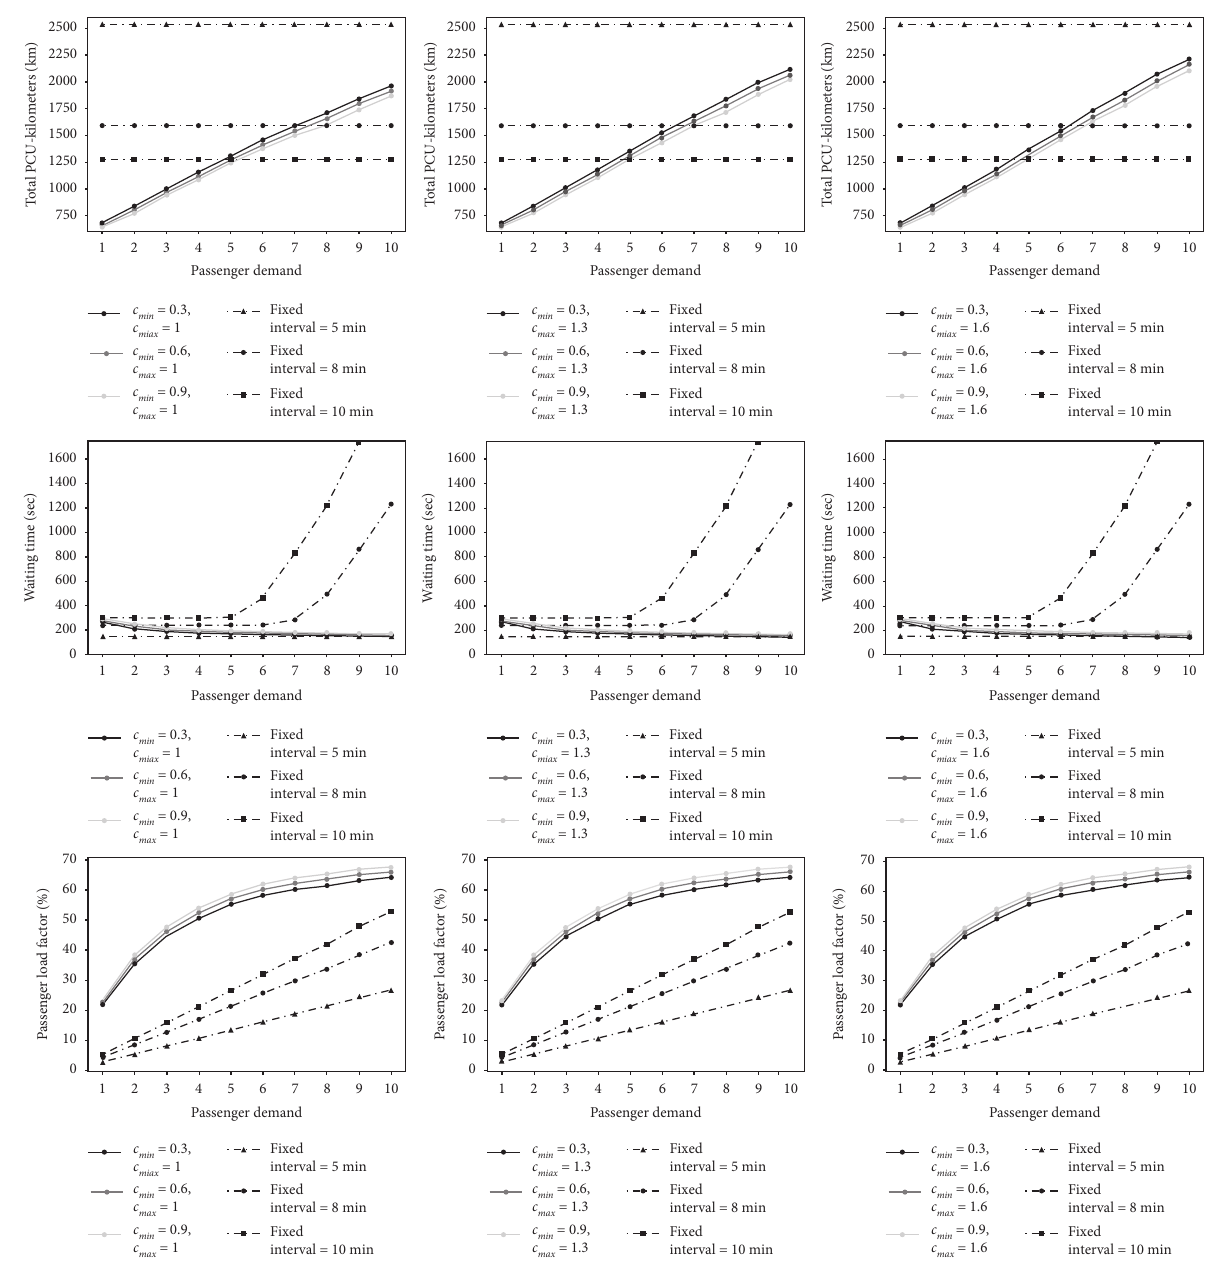
Figure 6: Simulation